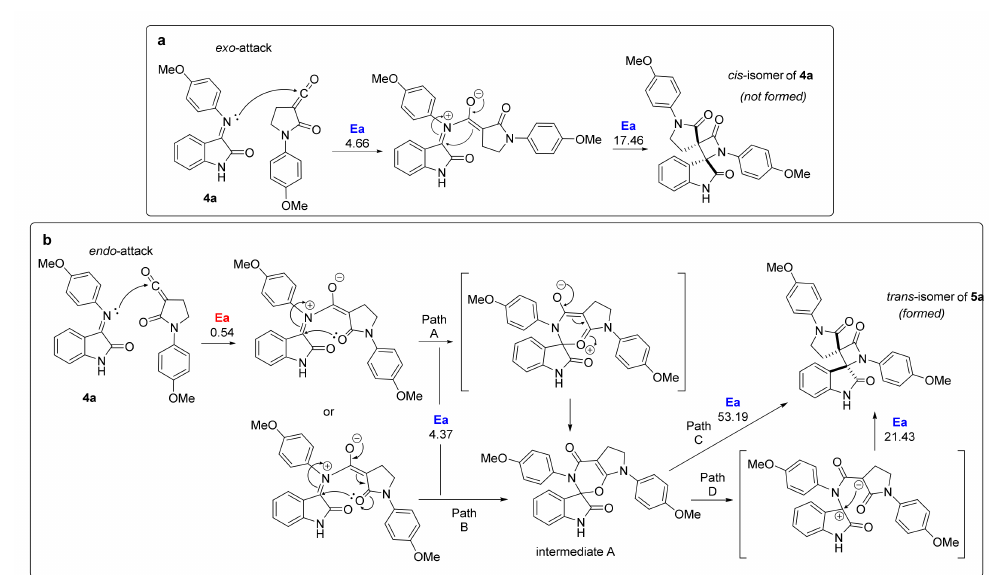
Figure 6. The presumable reaction mechanism for the compound 5a ’s formation and calculated activation barrier values (Ea, kcal/mol) for the exo- ( a ) and endo- ( b ) attack of E -imine 4a on ketene carbonyl group with the subsequent cyclization of the resulting zwitterionic